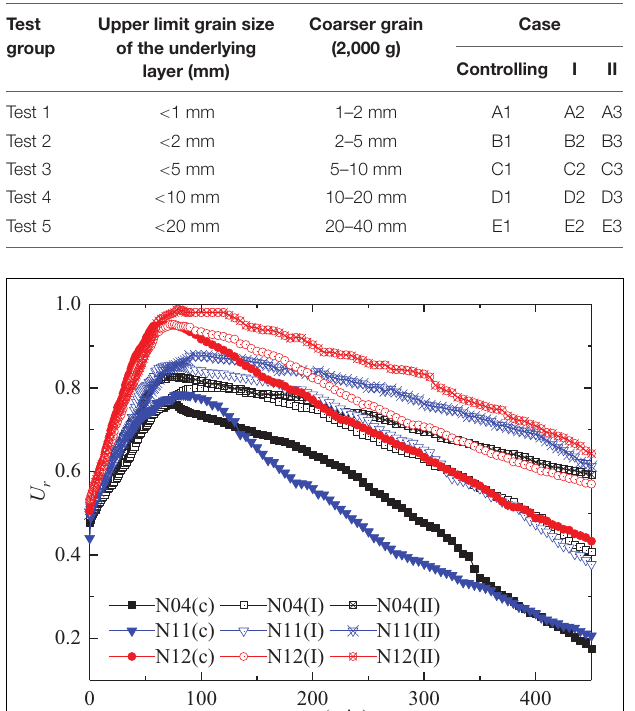
TABLE 3 | Test group information of deposition samples.